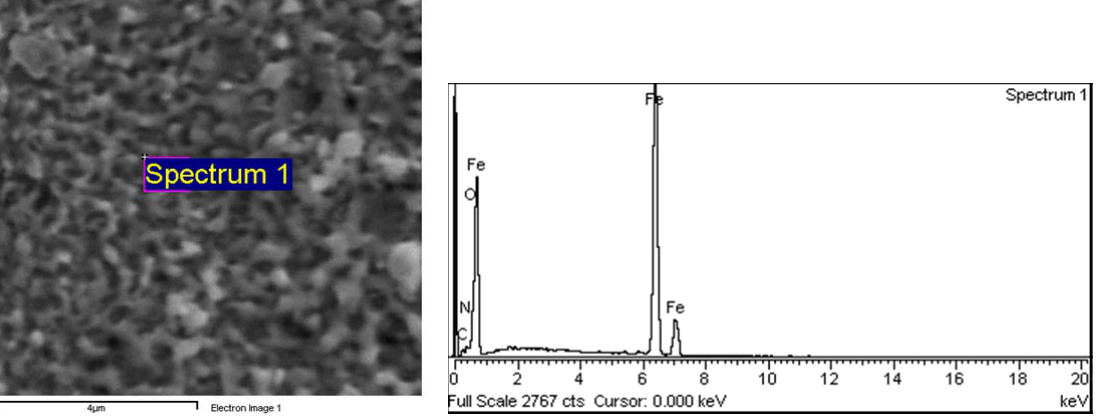
Figure 2. SEM and EDX analysis of steel C45 sample surface [6,